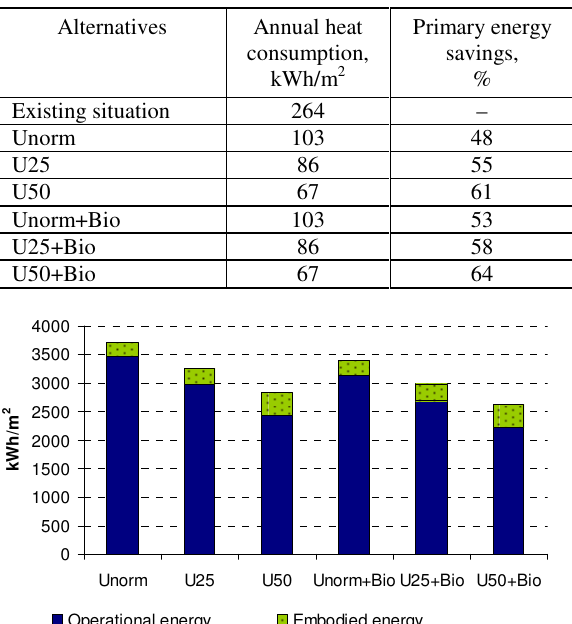
Table 2. Annual heat consumption and primary savings of